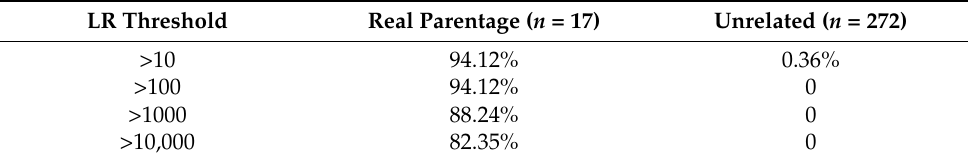
Table 3. Combined paternity index (CPI) distribution for real trios and unrelated trios with the